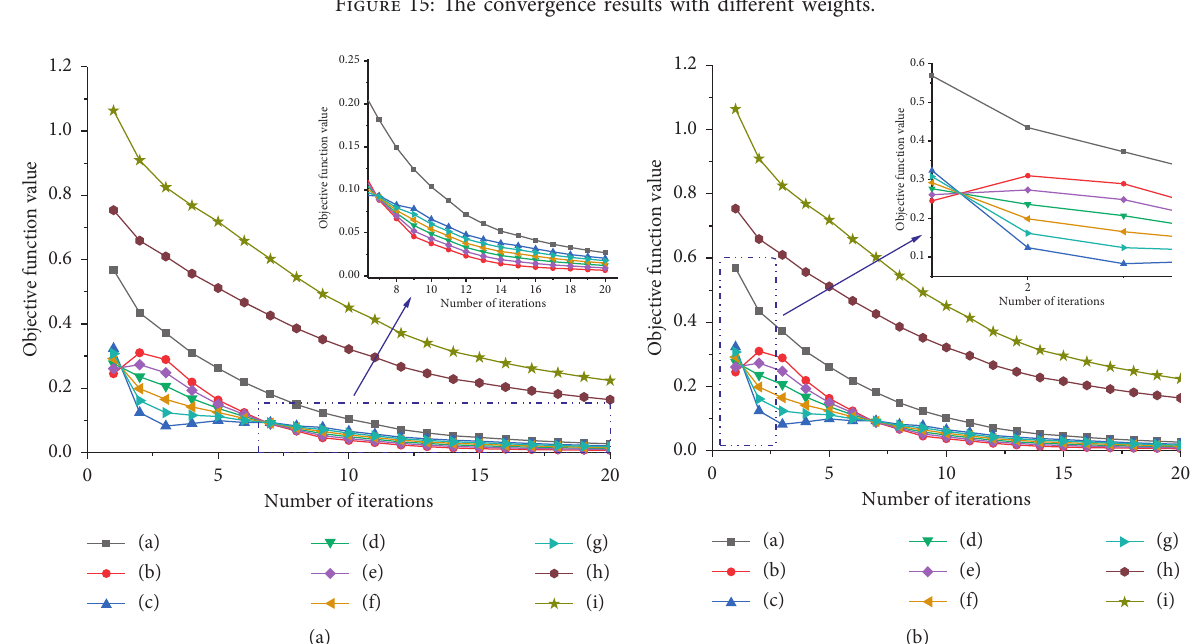
Figure 15: The convergence results with different weights.